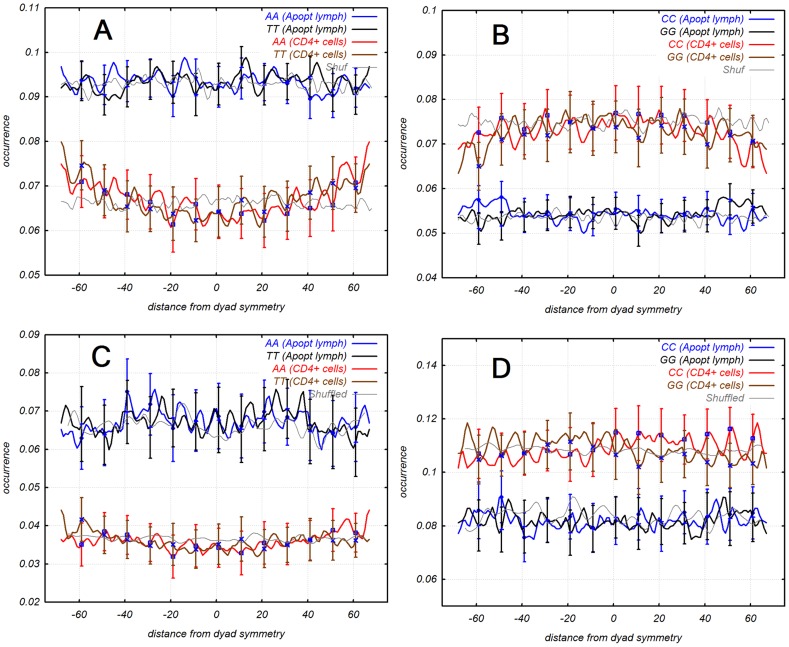
Dinucleotide distribution of +1 nucleosome. Group 1 (top panels) of apoptotic [14] + 1 nucleosomes has higher AT/GC ratio than set of normal CD4+ cells [8].Set of CD4+ has phased AA, TT dinucleotides and AA-TT peak at the center of nucleosome. Group 2 is at the bottom panel. +1 nucleosome of CD4+ cells has counter phased GG and CC dinucleotide.